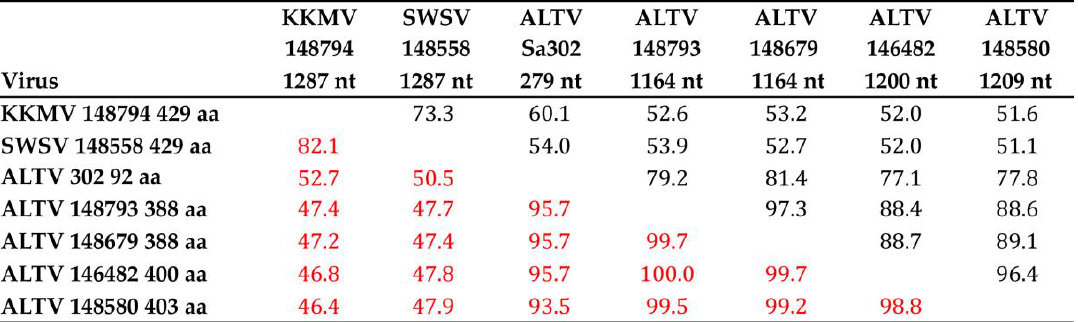
Figure 2. Pairwise alignment and comparison of nucleotide and amino acid S-segment sequences of Kenkeme virus (KKMV Sr422 / MSB148794), Seewis virus (SWSV Sca371 / MSB148558), Altai virus (ALTV Telet-Sa302) and representative ALTV-like hantaviruses (Sca363 / MSB146482, Sca370 / MSB148580, Sca402MSB148793, Sr424 / MSB148679). Nucleotide sequence similarities are designated in black and amino acid sequence similarities in red.